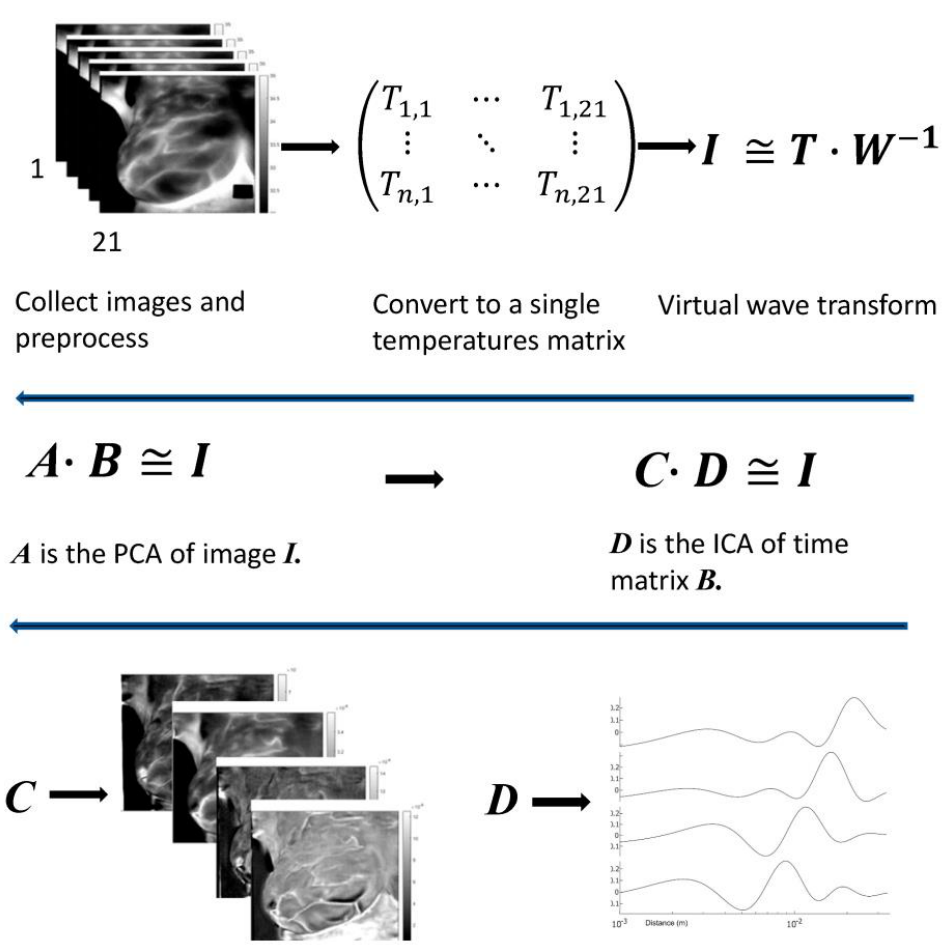
Figure 4. A simplified block diagram of the processing. n is a count of all the pixels included in the individual breast. A and C are image matrixes, and B and D are time matrixes. In the example given, matrix I is n × 100, A dimensions are 100 × 6, B dimensions are 6 × n , C dimensions are n × 4, and D dimensions are 4 × 100 .